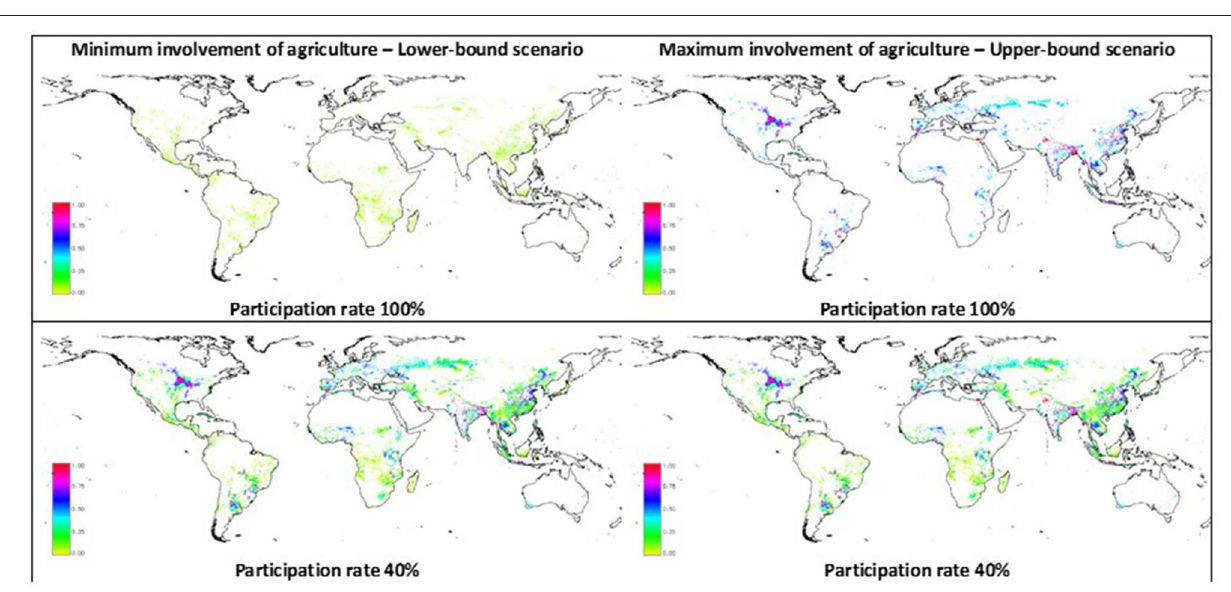
FIGURE 4 | Location and density of cropland in areas targeted by restoration efforts. The legend reports the fraction of cropland area in each grid cell.